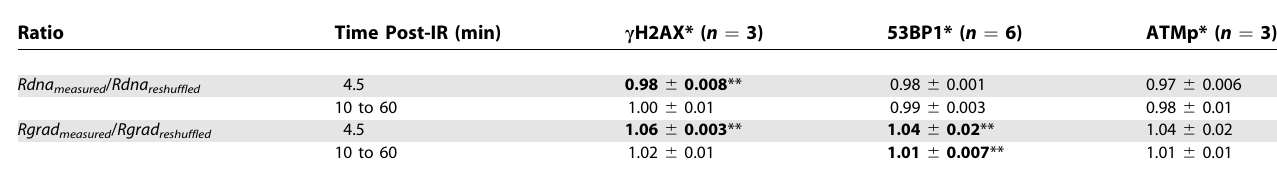
Table 3. Experimental Relative DNA Measurements Normalized to Predicted-for Exposure for 1 Gy of c -Rays Ratio Time Post-IR (min) Rdna measured / Rdna